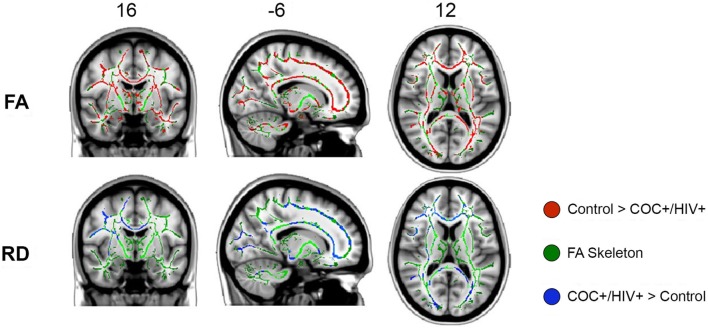
Tract-based spatial statistics results: fractional anisotropy (FA) and radial diffusivity (RD) white matter regions showing statistically significant decreases in FA (red) and increases in RD (blue) in COC+/HIV+ subjects compared with controls. All images are presented in radiological convention.